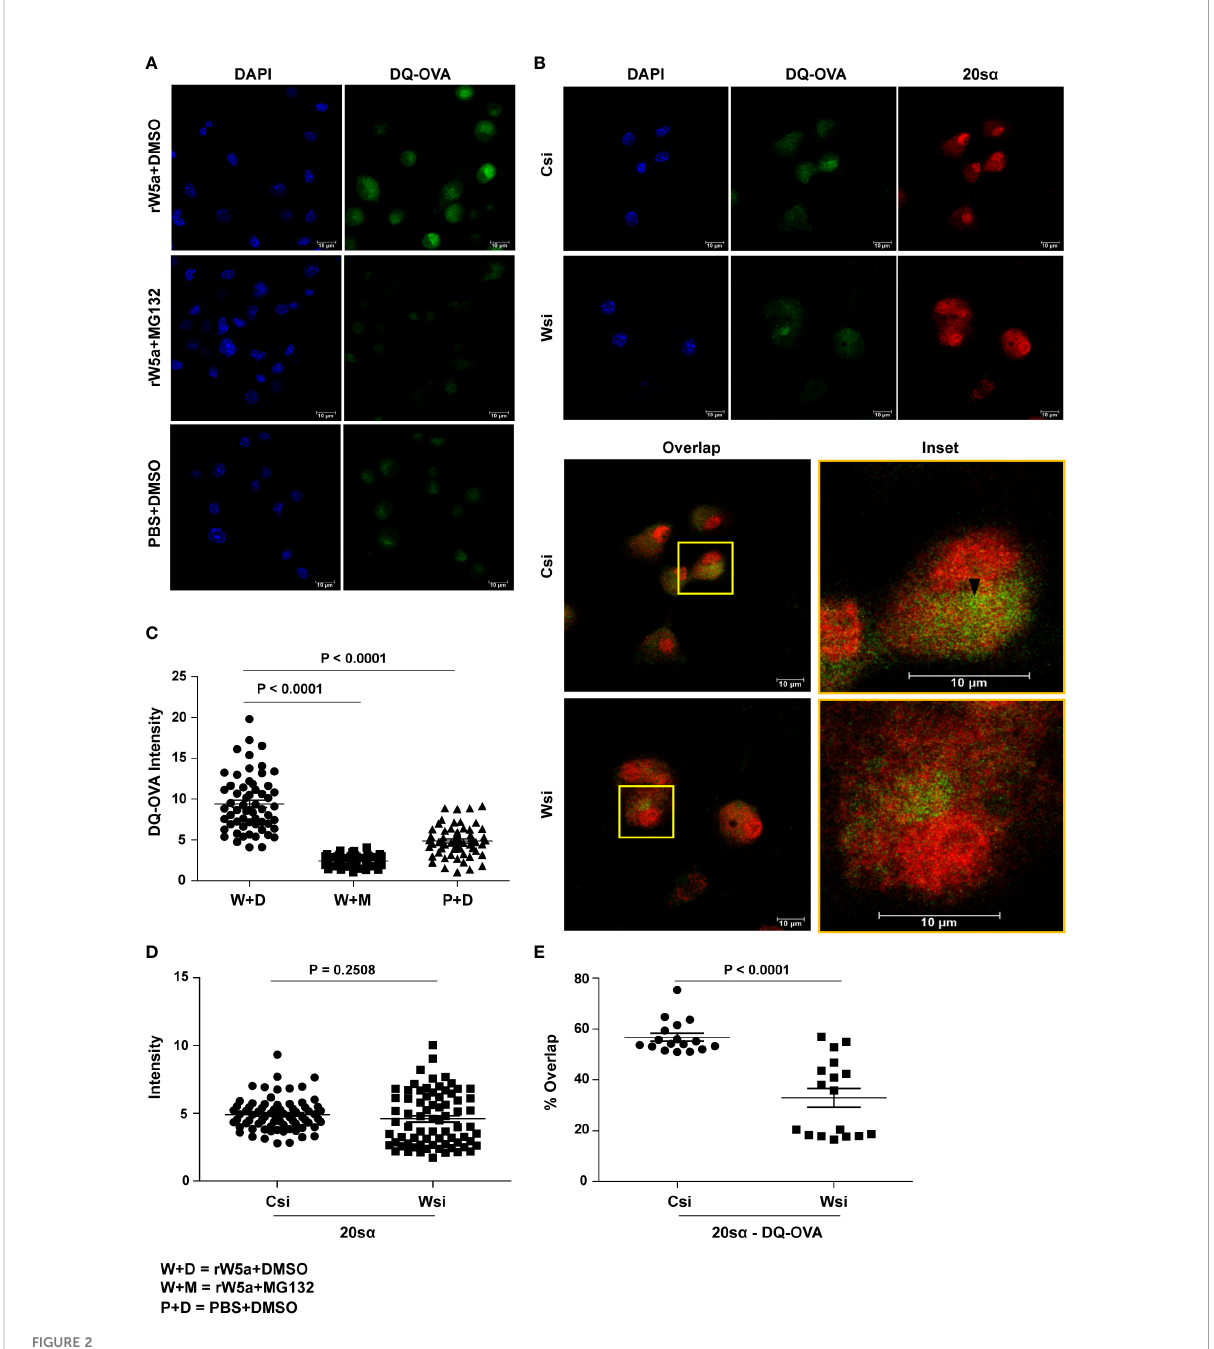
FIGURE 2 Wnt5A mediated DQ-OVA processing in BMDC is associated with proteasome activity: (A, C) : Confocal microscopy of rWnt5A (rW5A) conditioned BMDC samples with or without MG132 (A) and corresponding ImageJ analysis of DQ-OVA intensity (C) (n = 2, each dot representing a cell) demonstrate MG132 mediated blockade in rW5a induced increase in DQ-OVA fl uorescence. PBS (P) and DMSO (D) are vehicle controls for rW5a (W) and MG132 (M) respectively. DAPI (blue) fl uorescence denotes the nuclei. B, D, and E: Confocal microscopy (B) along with ImageJ intensity measurement (D) (n = 2, each dot representing a cell) and Mander ’ s overlap coef fi cient analysis (E) (n = 2, 17 fi elds, each dot representing a fi eld) demonstrate that with no signi fi cant change in 20S proteasome subunit a intensity in Wsi (Wnt5A depleted) BMDC as compared to Csi (control), there is a signi fi cant decrease in the DQ-OVA-20S a overlap intensity indicating reduced DQ-OVA processing. Overlap of DQ-OVA with the 20S a is emphasized in inset (B) . The arrow mark (black) shows overlap (yellow spots). Magni fi cation: 63X (2X zoom). The bar represents mean ± SEM (Standard error of the mean) with exact p values depicted in the fi gure. n represents the number of independent experiments. For all calculations, Student ’ s Unpaired t-test was